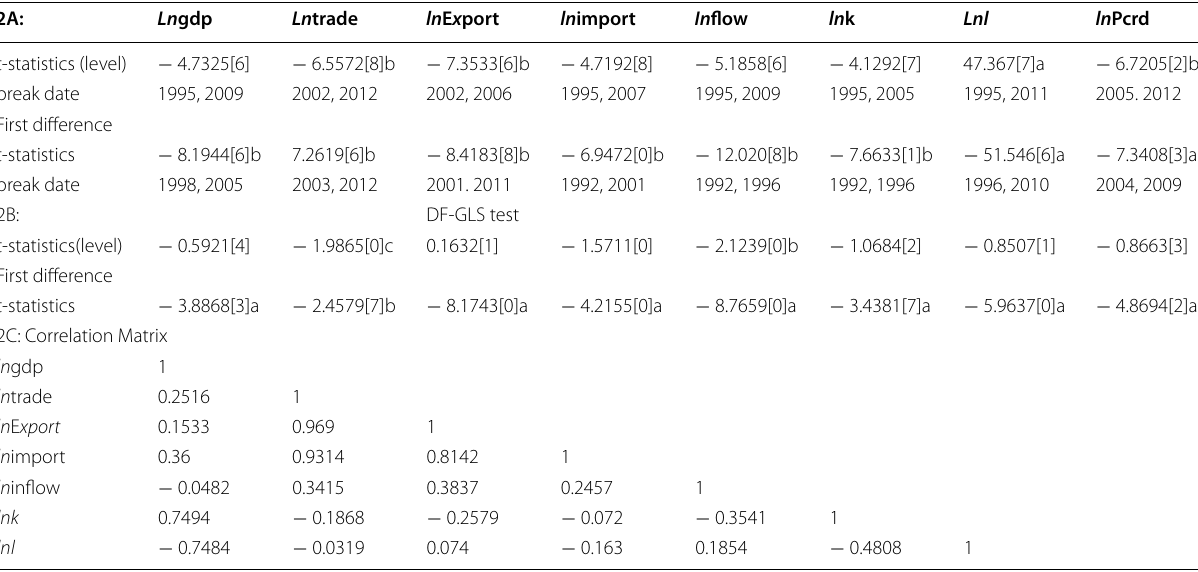
Table 2 Lee and Strazicich [46] LM unit root test with two structural breaks, DF-GLS unit root test and correlation matrix